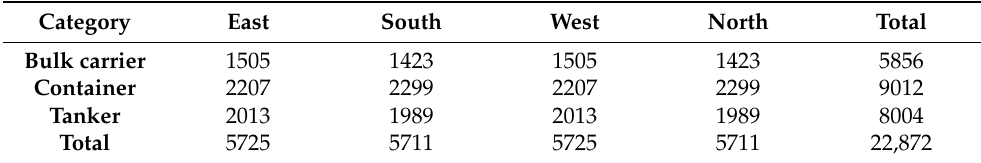
Table 2. The number of cargo ships used per category after applying augmentation techniques.